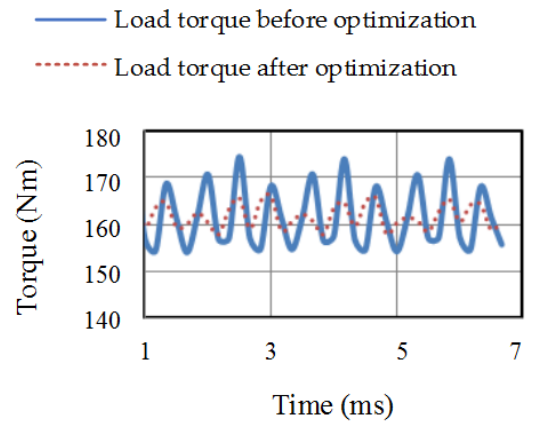
Figure 14. Torque of the AFPMSM at the rated load power.